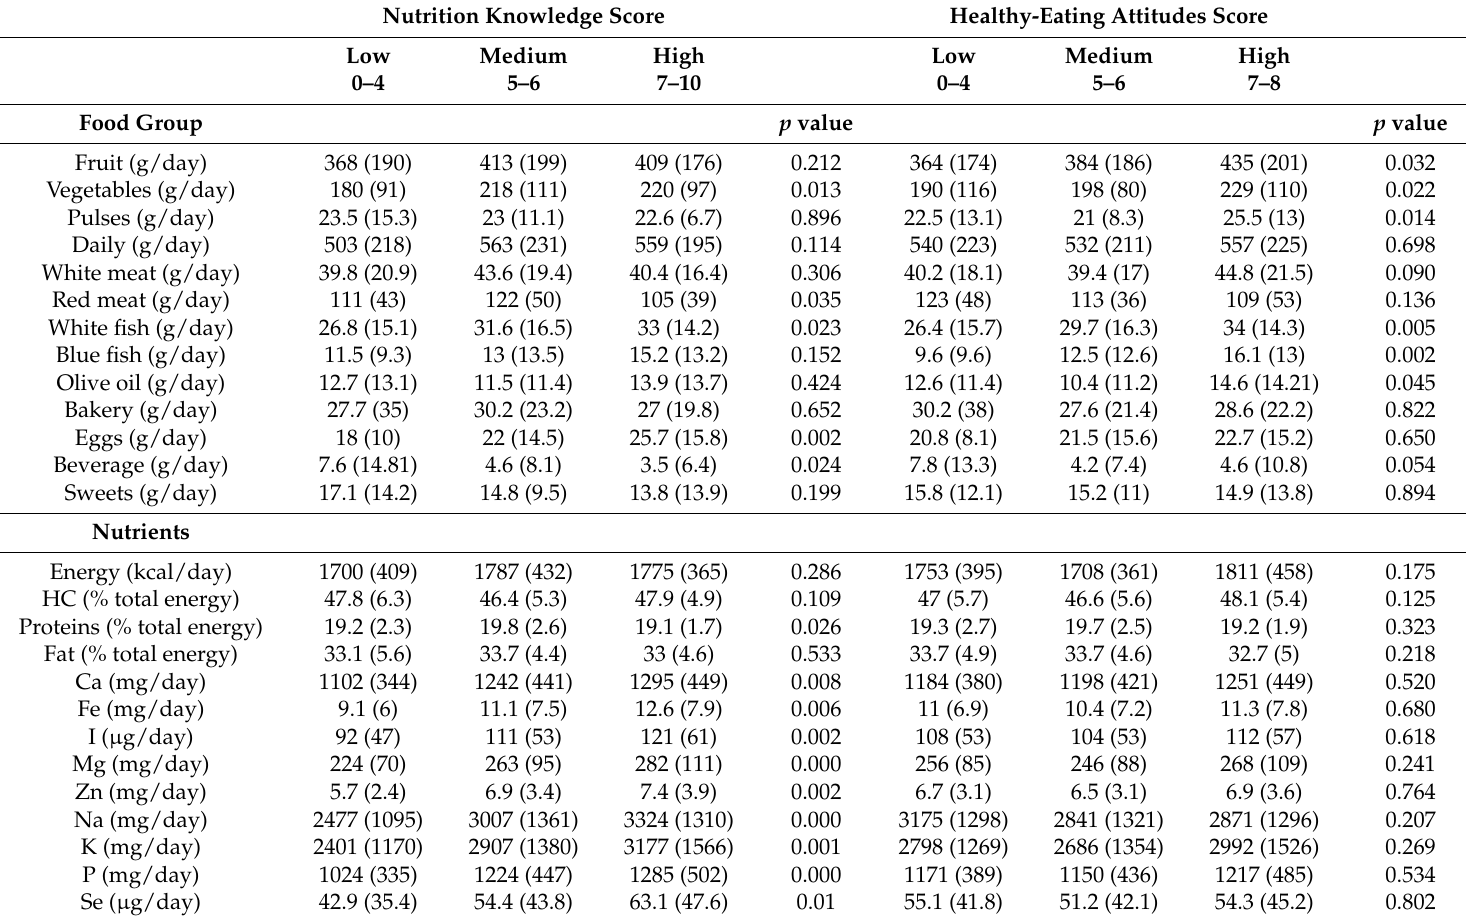
Table 2. Mean food and nutrients intakes among the 287 participants of the SENDO project according to the nutrition knowledge score and healthy-eating attitudes score (Mean values and standard